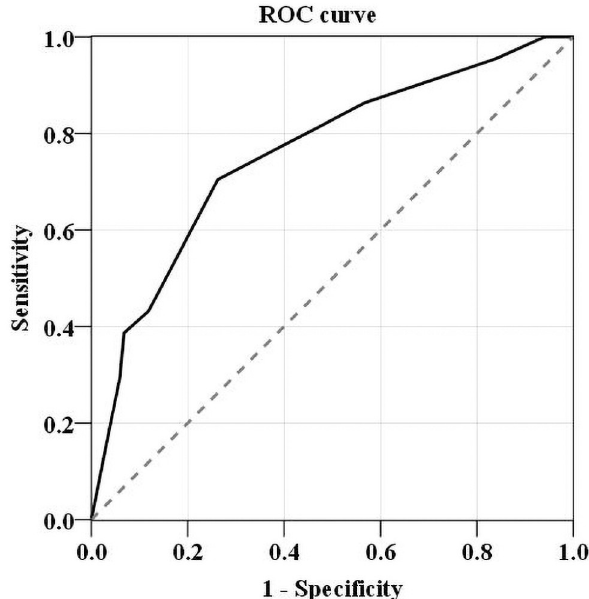
Among the 162 participants, the cut-off Sniff Bubble score in the Cog-D group was 3 with an AUC of 0.759 (95% CI: 0.673–0.844, p < 0.001) (Fig 4). As shown in Table 3, the sensitivity + specificity value was the highest for Sniff Bubble scores of 3.